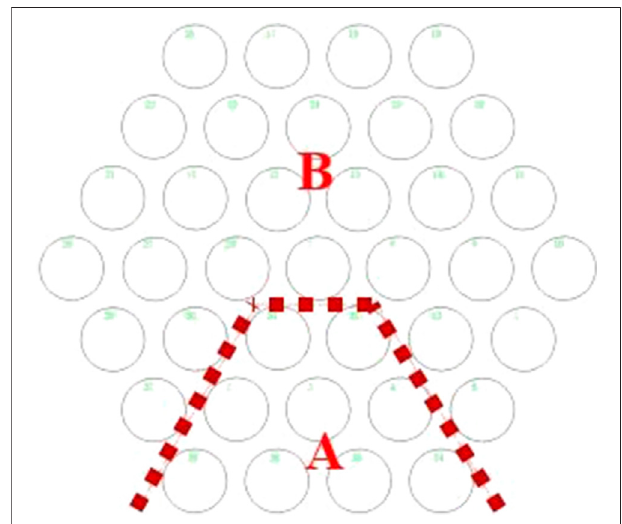
FIGURE 6 | Schematic of the arrangement and number of heating